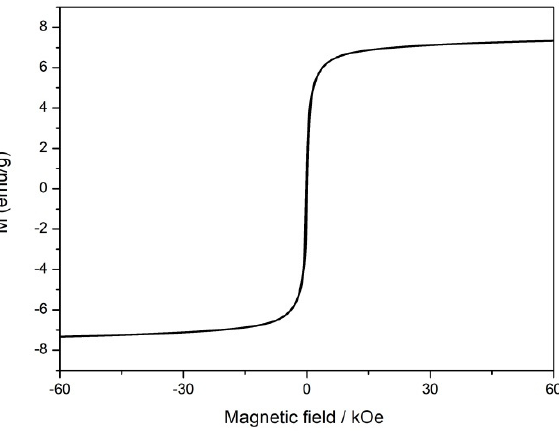
Figure 6. Magnetic hysteresis loops of the CFeN@rGO-COOH